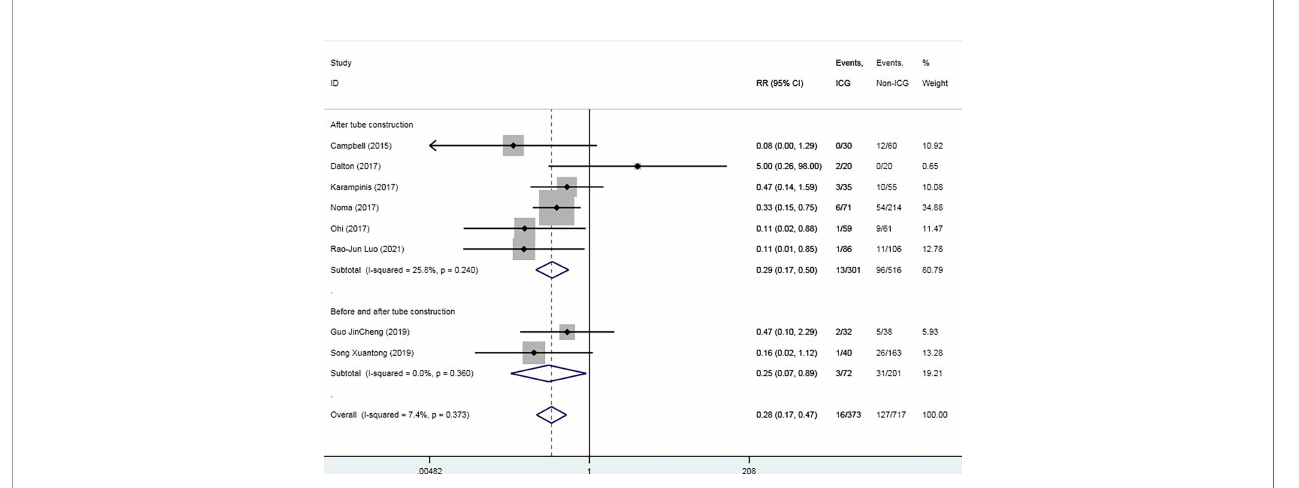
FIGURE 5 | Forest plot for subgroup analysis of anastomotic leak based on indocyanine green fl uorescence intervention